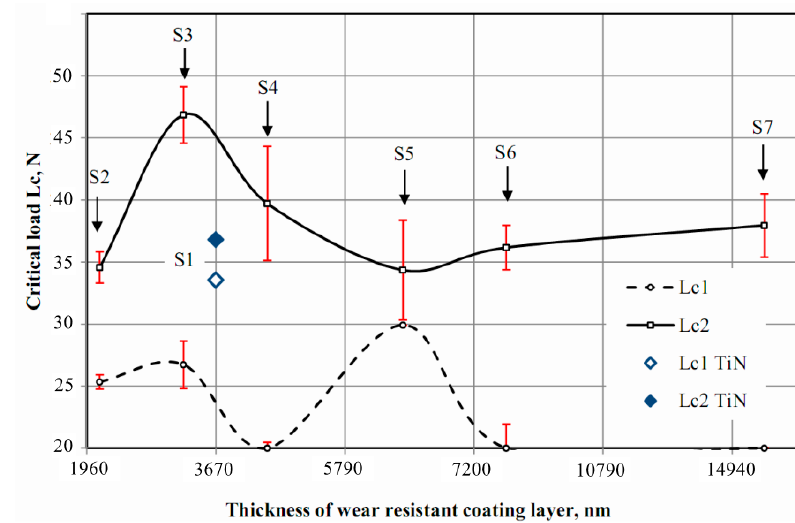
Figure 12. Relationship between critical loads at scratch testing and the thickness of the wear-resistant coating layer.